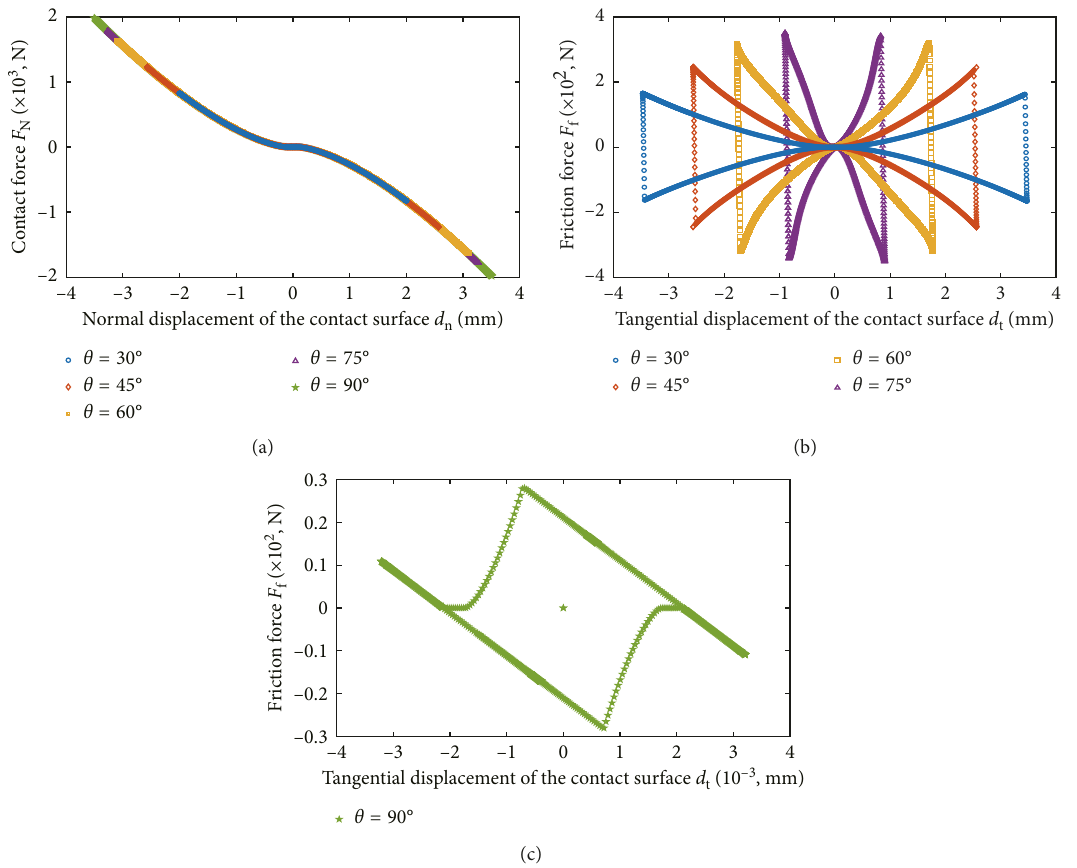
Figure 8: The curves of force at different angles. (a) Contact forces. (b) Friction forces (30 ° , 45 ° , 60 ° , and 75 ° ). (c) Friction forces (90 °